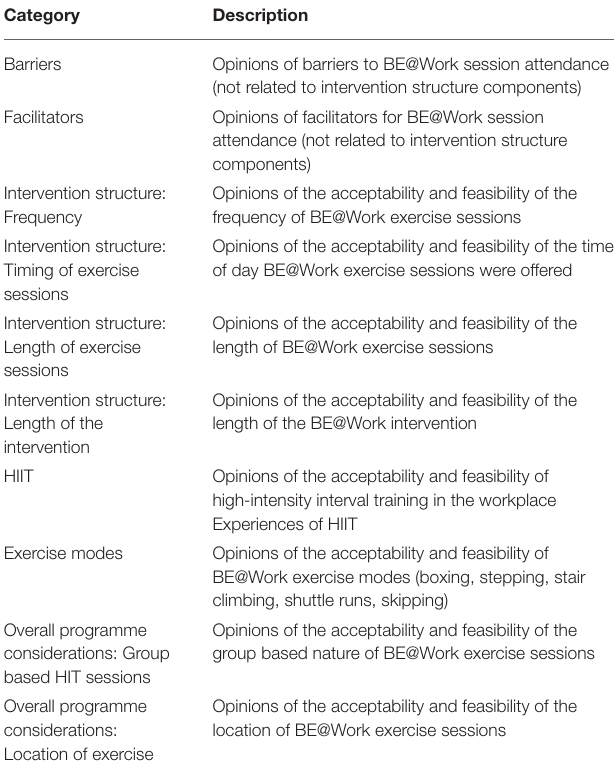
TABLE 2 | Focus group categorisation